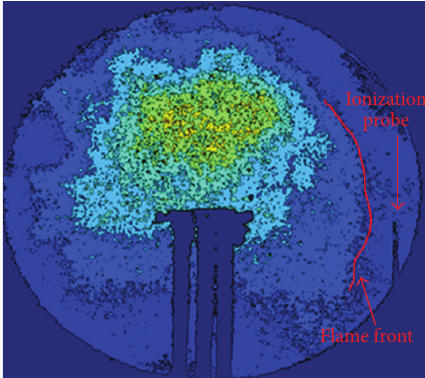
Figure 2: Qualitative shadowgraph measurement used to verify the time-of-arrival of the flame to the ionization probe. Image was taken prior to the flame reaching the probe.